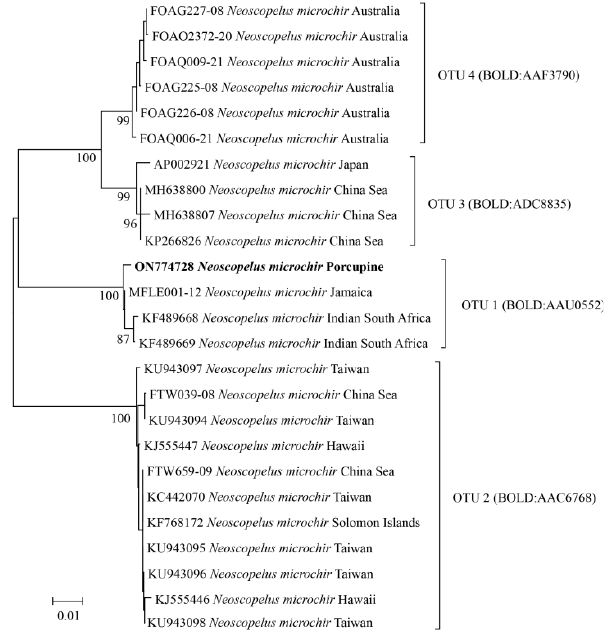
Figure 3. Neighbor-Joining cladogram of the COI marker of Neoscopelus microchir specimens. There were 652 positions in the final sequence alignment. The numbers at the nodes indicate the percentage of tree resampling per bootstrap. The scale indicates the number of substitutions per nucleotide. The sequence of the specimen captured in Porcupine Bank is marked in bold. The correspondence between OTUs and BOLD BINs is also shown. Table 1. Measurements and counts of specimen of Neoscopelus microchir MHN USC 25200 from Porcupine Bank and compared with the previous records from the Galicia Bank [19]. % LS: percentage of each measurement with respect to the Standard length